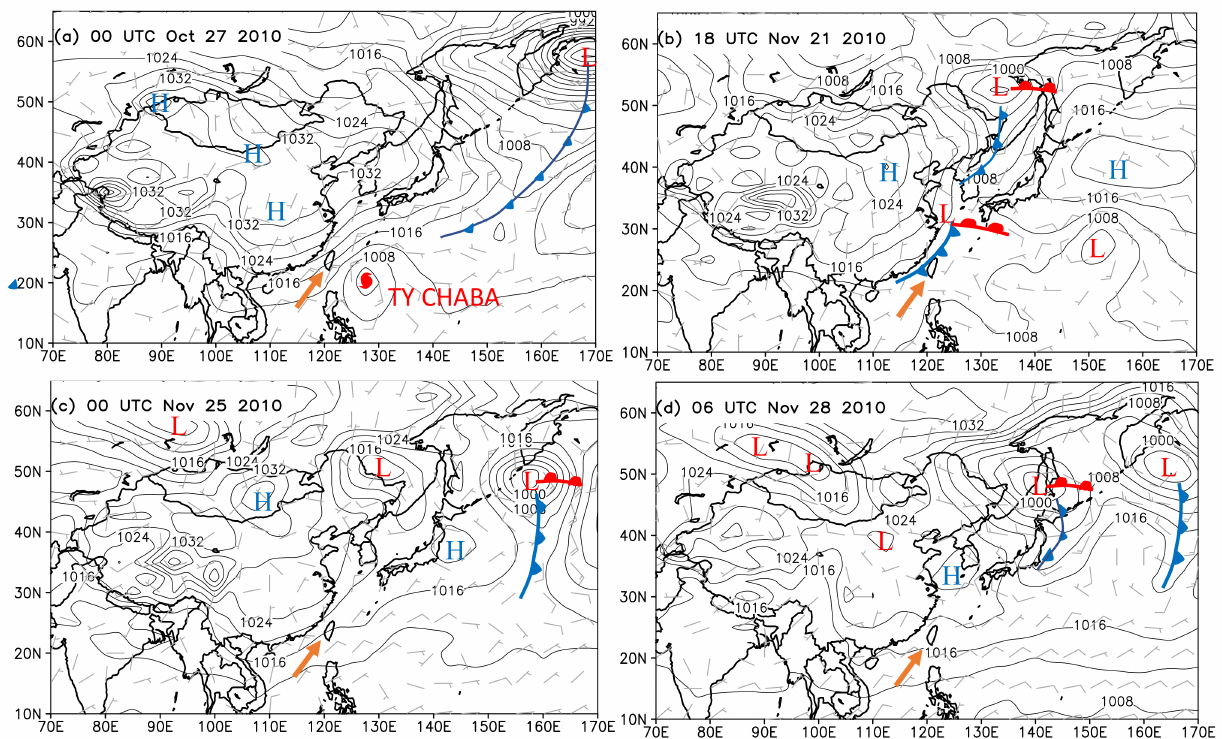
Figure 4. Surface weather maps of ( a ) typhoon (TY Chaba) type at 00:00 UTC on 27 October 2010; ( b ) ahead of front in non-typhoon type at 18:00 UTC on 21 November 2010; ( c ) ahead of anticyclone in non-typhoon type at 00:00 UTC on 25 November 2010; and ( d ) behind anticyclone in non-typhoon type at 06:00 UTC on 28 November 2010. The full barb and half barb represent 10 and 5 m s − 1 , respectively. Isobars (line) are analyzed at 4 hPa interval. Taiwan is marked with an arrow. Note that the universal time in the weather map plus 8 h is the local time (created by data from the National Centers for Environmental Prediction,